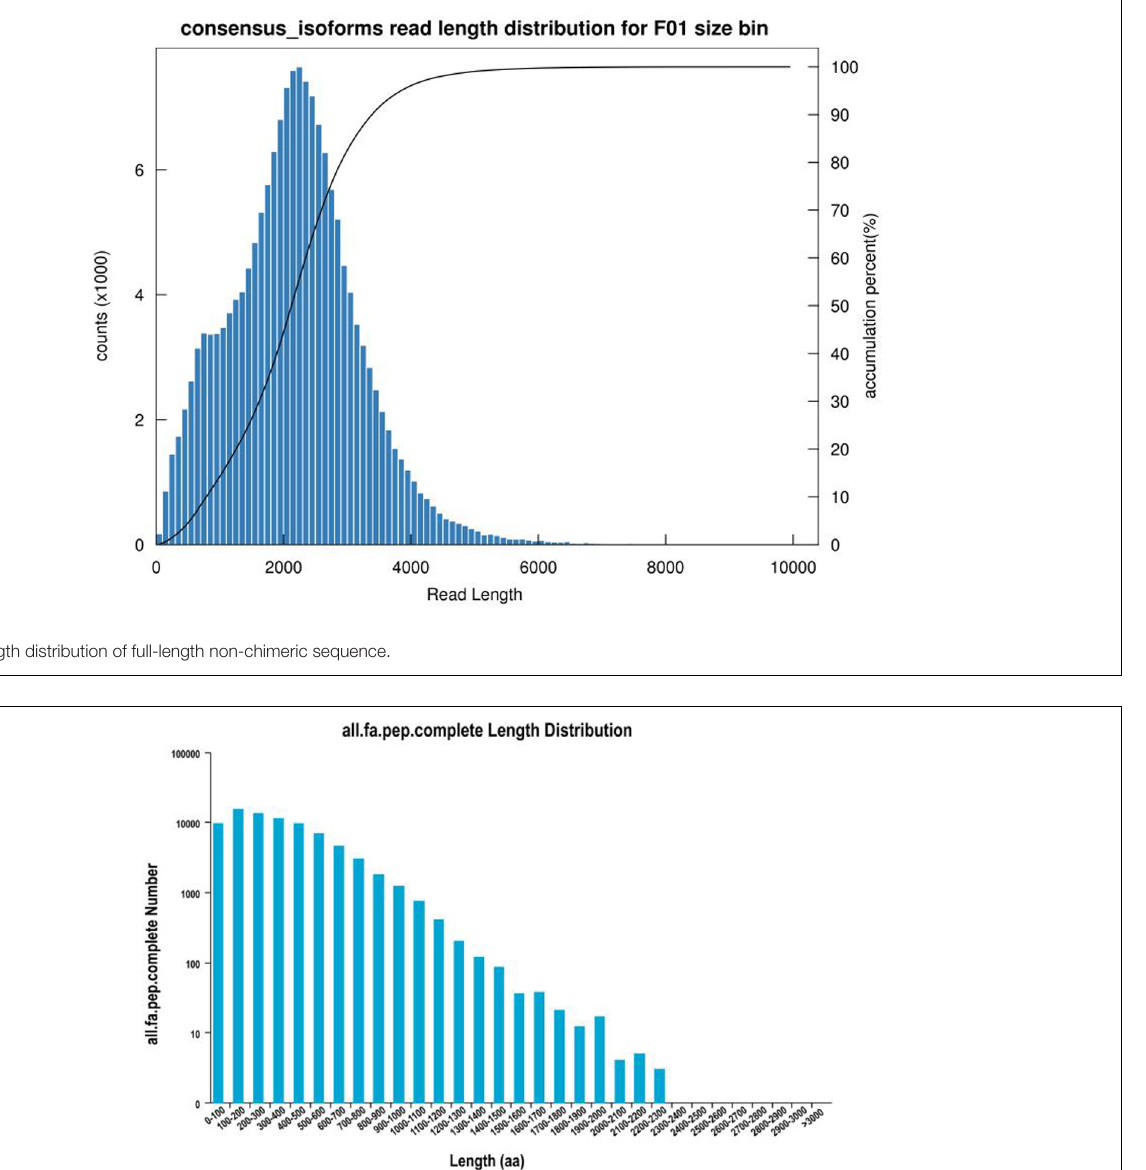
FIGURE 2 | Division of predicted CDS-encoded protein